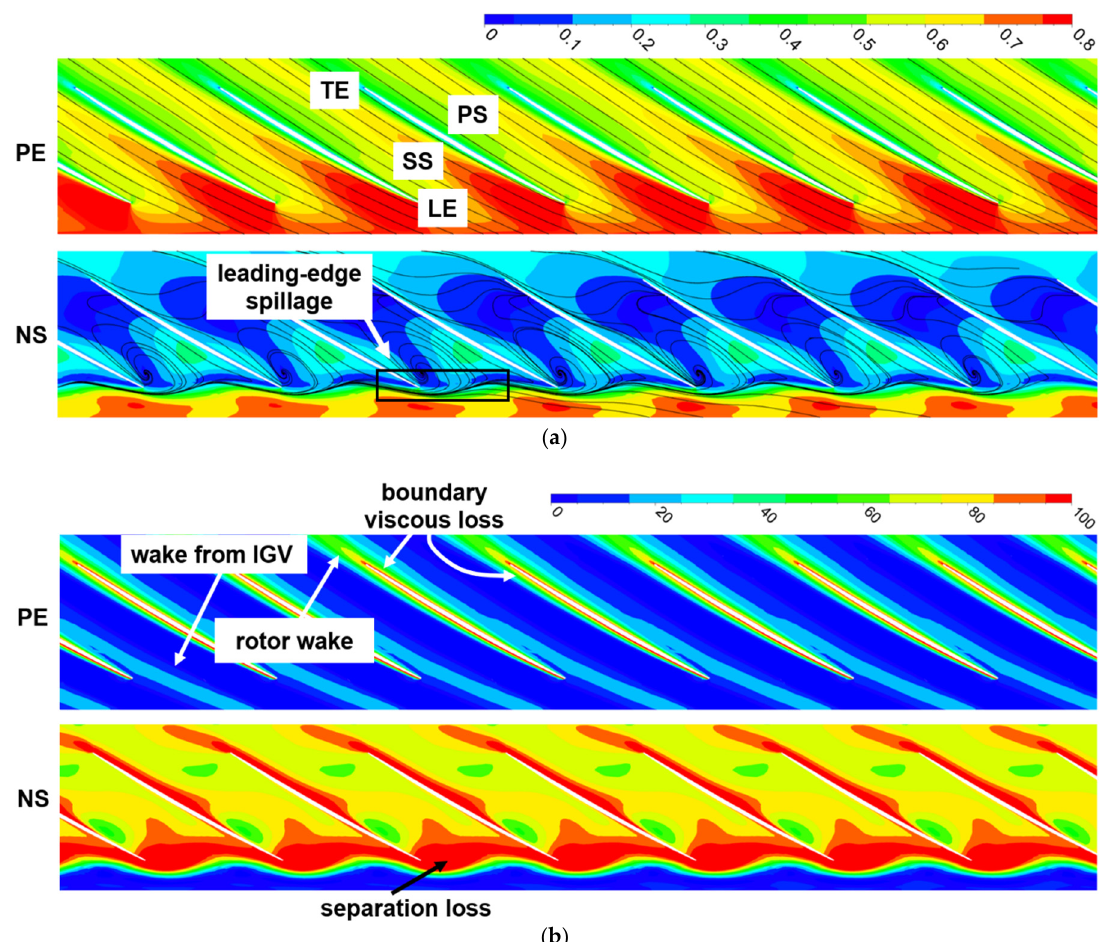
Figure 9. Time-averaged results at 96% of span. ( a ): Relative Mach contours with streamline of relative velocity. ( b ): Entropy contours (J/(kg K)).